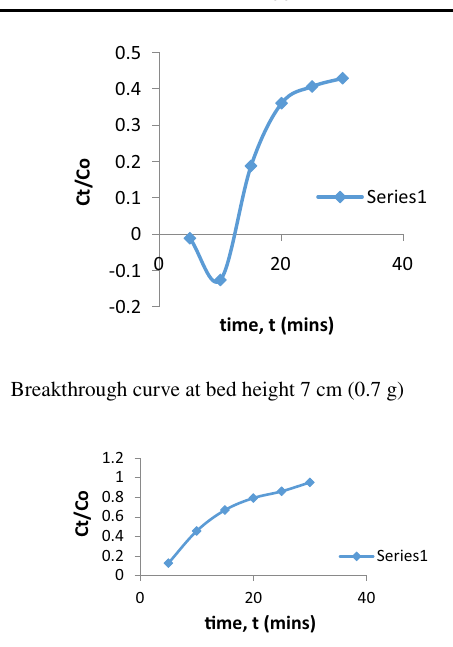
Fig. 8 Breakthrough curve at flow rate 2.23 mL/min